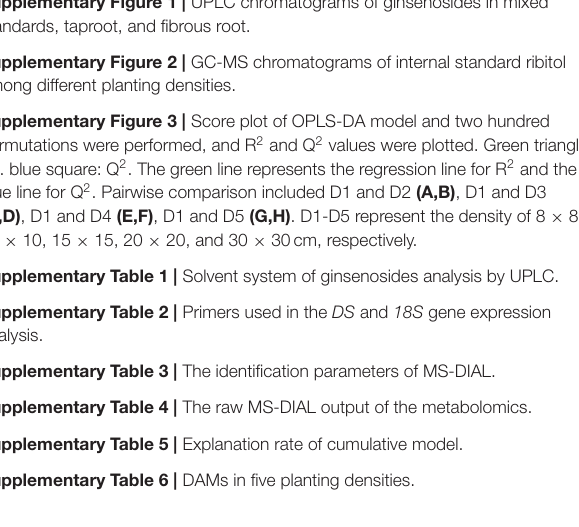
Supplementary Table 1 | Solvent system of ginsenosides analysis by UPLC. Supplementary Table 2 | Primers used in the DS and 18S gene expression analysis. Supplementary Table 3 | The identification parameters of MS-DIAL. Supplementary Table 4 | The raw MS-DIAL output of the metabolomics. Supplementary Table 5 | Explanation rate of cumulative model. Supplementary Table 6 | DAMs in five planting